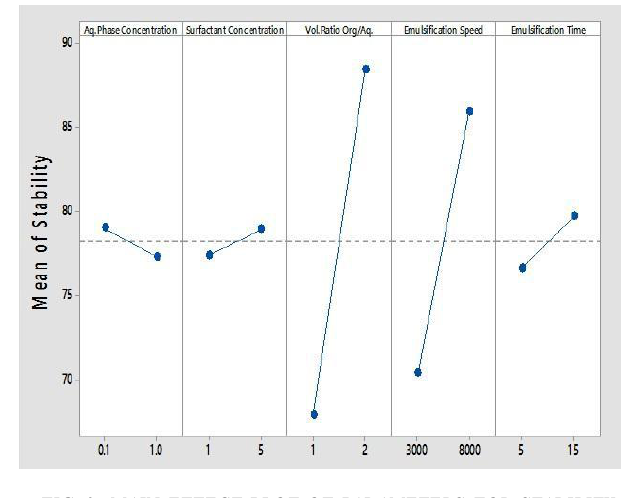
FIG. 2. MAIN EFFECT PLOT OF PARAMETERS FOR